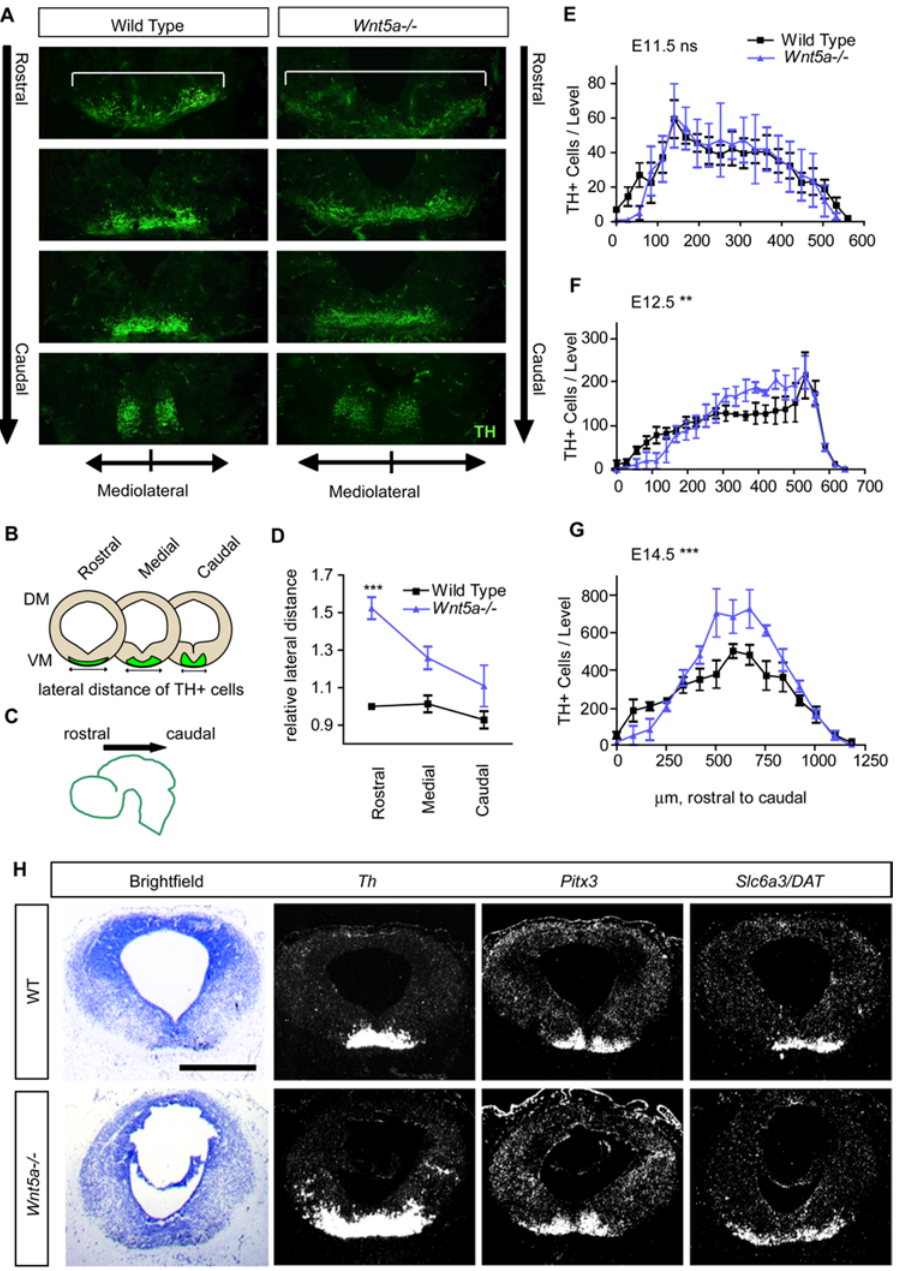
Figure 8. The distribution of TH + cells in the rostrocaudal and mediolateral axis is altered in Wnt5a 2 / 2 mice. (A) At E12.5, there is a redistribution of TH + cells in the VM, both in the rostrocaudal and mediolateral axis. (B) Three representative levels throughout the VM were measured for lateral spread of TH + cells: rostral, medial and caudal. ImageJ was used to measure the distance between the two TH + cells furthest apart in (D). (C) TH + cells were quantified at regular intervals from rostral to caudal midbrain in (E–F). (D) TH + cells are distributed much more broadly in anterior midbrain of E12.5 Wnt5a 2 / 2 mice compared to WT (ANOVA, N=3, p , 0.001). (ANOVA with Bonferroni’s post test, Rostral WT vs Rostral Wnt5a 2 / 2 p , 0.001). (E–F) Rostrocaudal distribution of TH + cells. (E) At E11.5 no difference could be seen between the distribution of TH + cells in the anteroposterior axis of WT or Wnt5a 2 / 2 mice. However, at E12.5 (F) and E14.5 (G) an altered distribution with a decrease in the number of TH + cells in anterior levels and an increase in medial levels was seen (Two way ANOVA, for level and genotype, P=0.0016 at E12.5, P , 0.0001 at E14.5, N=4). (H) The lateral expansion of TH + cells at E12.5 was confirmed by in situ hybridization for Th , Pitx3 and DAT , two other markers of maturing dopaminergic